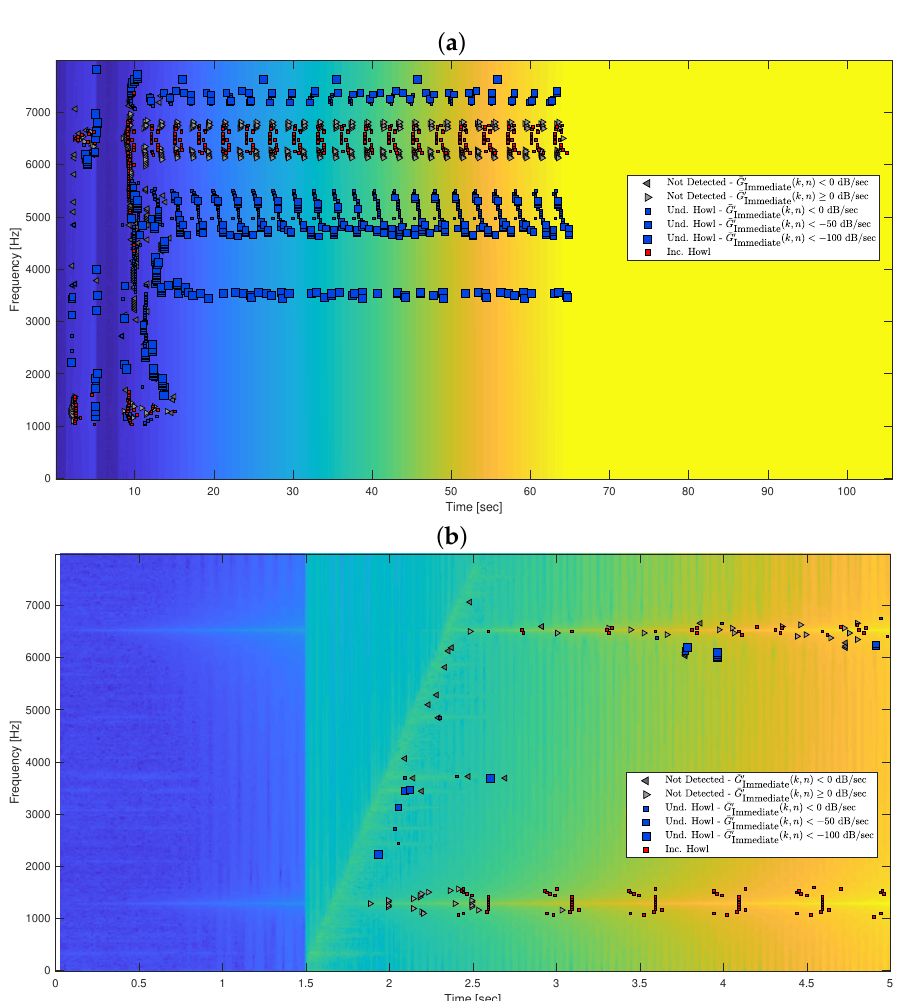
Figure 9. Spectrogram of the SR system’s output within the simulated study room, where the amplification gain is above the MSG, and the united retrospectively detected howling artifacts. Considering the Soft MSD-based with FA Detection detector, increasing howls are colored red; underdamped howls are colored blue and separated by their magnitude-slope; and undetected frequency-howls are colored in shades of gray and marked with arrows to indicate the slope of the suspected frequency-howl. ( a ) Entire Output Signal and Howling Detection; ( b ) Chirp Signal and Howling